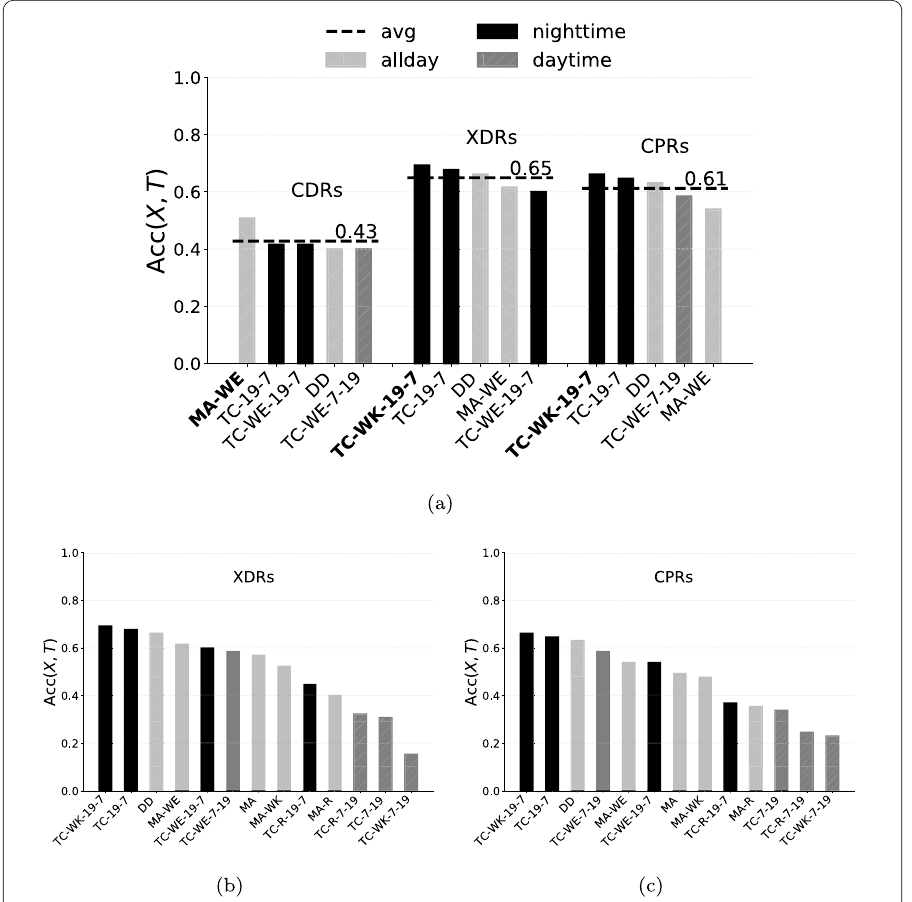
Figure 5 ( a ) Home detection accuracy of the top five HDAs for each stream. Dark bars indicate algorithms based on nighttime records, dark grey bars indicate those based on daytime records, light grey bars indicate those using records during all day. The dashed line indicates the average accuracy across the top five HDAs. In the x axis, we highlight in bold the best combination of stream and HDA. ( b ) Home detection accuracy of 13 HDAs for XDRs. ( c ) Home detection accuracy of 13 HDAs for